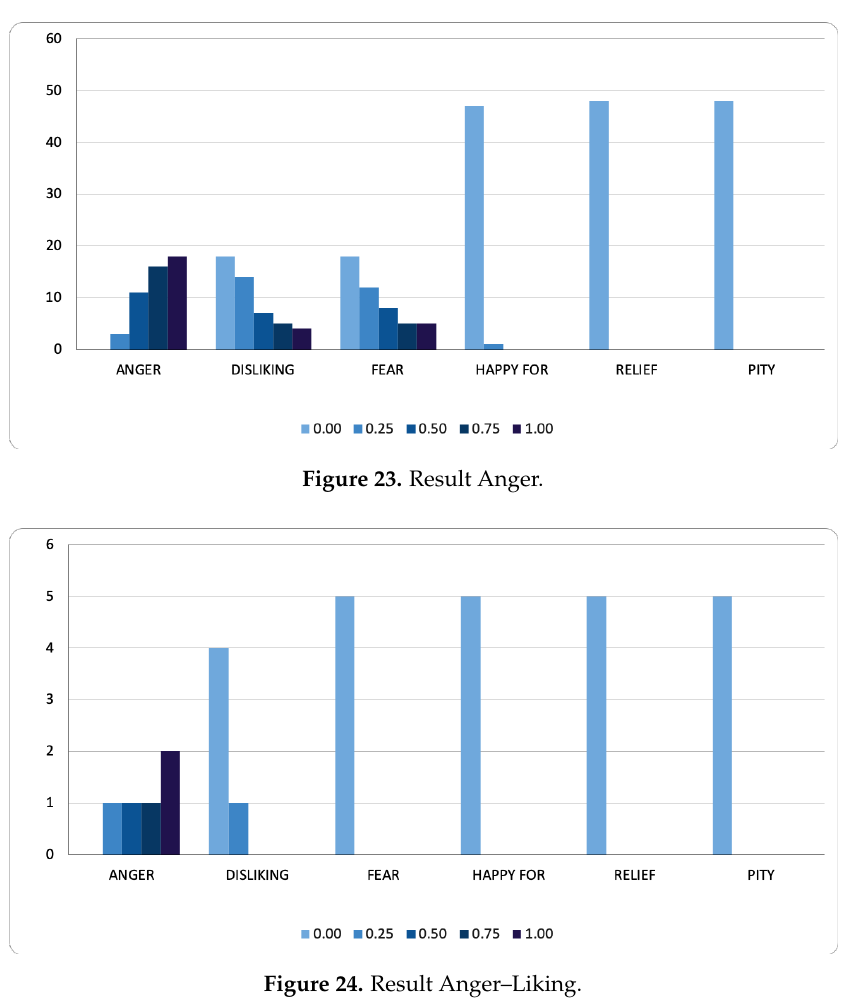
Figure 24. Result Anger–Liking.